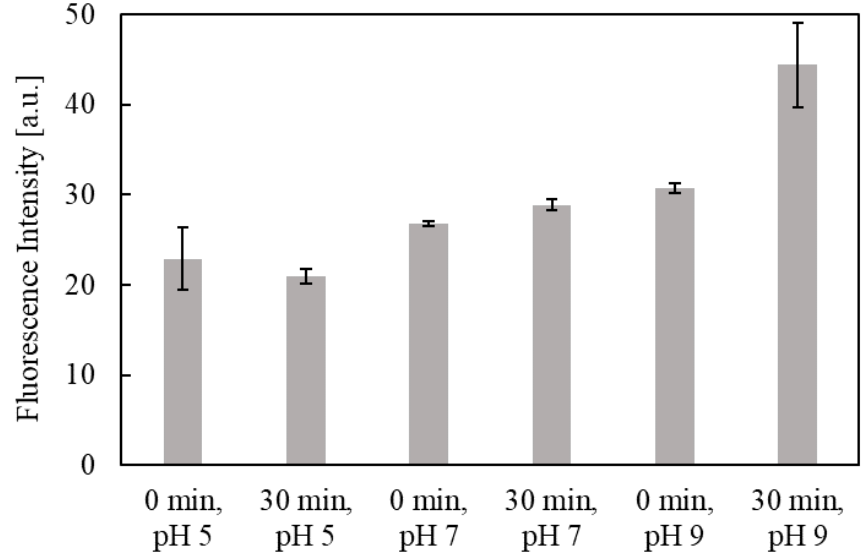
Figure 7. Fluorescence intensities of the acidic, neutral, and alkaline solutions without bubbles (0 min bubbling time) or with bubbles after 30 min of bubbling time, using aminophenyl fluorescein as the fluorescent probe for · OH detection (error bars illustrate standard deviations).